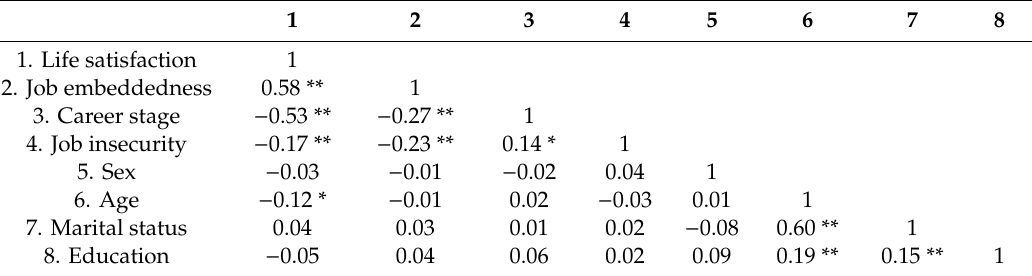
Table 1. Mean, standard deviation, and bivariate correlation of research variables.